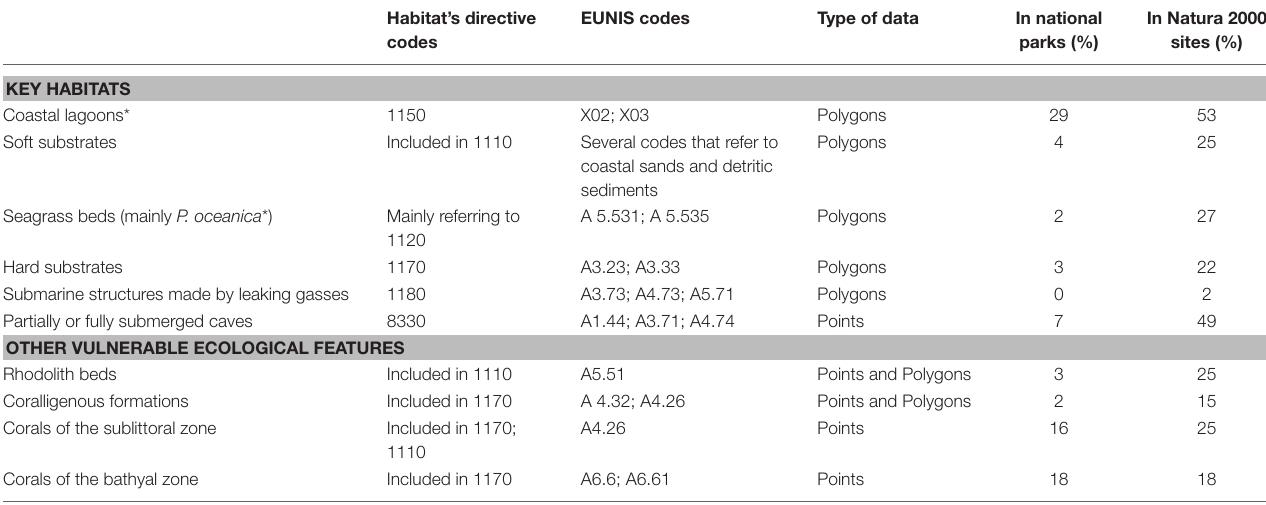
TABLE 2 | List of key marine habitat types and other vulnerable ecological features whose distribution was investigated in the present study, and their associated habitat type codes according to two habitat classification systems: the Habitats Directive 92/43/EEC and the European Nature Information System